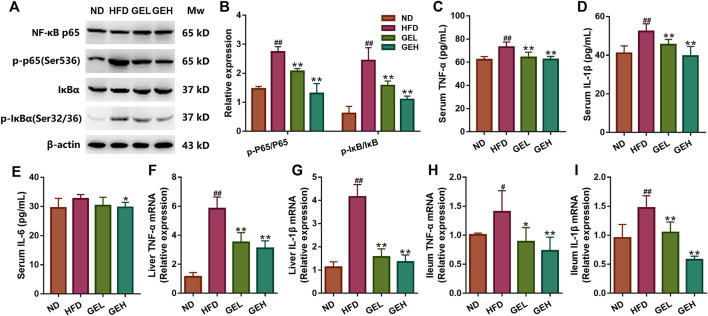
Effects of GE treatment on inflammation in HFD-fed mice. (A–B) Phosphorylation levels of NF-κB p65 (Ser 536) and IκB (Ser 32/36) in total liver homogenates. The bands were quantified, and the values are relative to the β-actin levels (loading control). (C–E) Circulating TNF-α, IL-1β and IL-6 levels. (F–I) Relative mRNA expression of TNF-α and IL-1β in ileum and liver tissues. n = 8 per group. #
p <0.05 or ##
p <0.01 vs. the ND group. *p <0.05 or **p <0.01 vs. the HFD group.